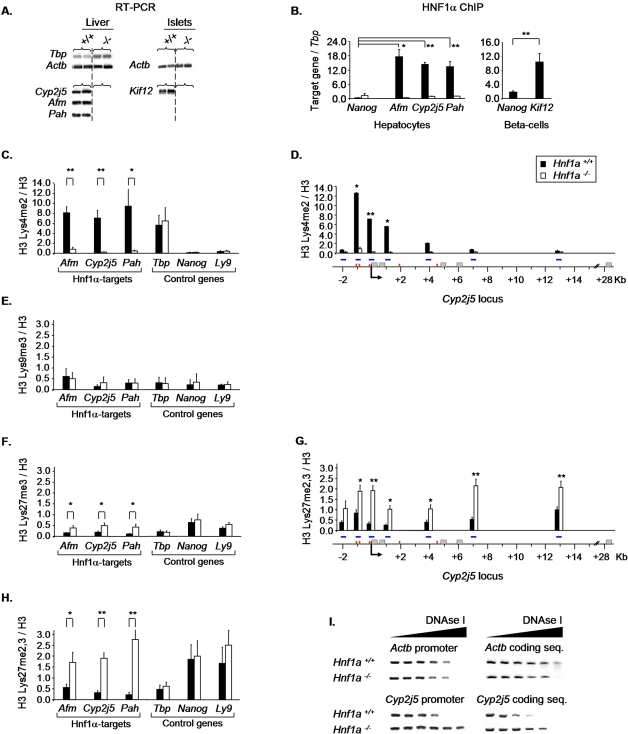
Inactive Hnf1α targets in Hnf1a−/− cells exhibit local enrichment of H3-Lys27me3, decreased H3-Lys4me2, and reduced DNAse I sensitivity.(A) RNA expression of tissue-specific Hnf1α targets (Afm, Cyp2j5, Pah, Kif12) and control genes (Tbp, Actb) in Hnf1a+/+ and Hnf1a−/− liver and islets. (B) ChIP analysis of Hnf1α occupancy in the promoter region of tissue-specific targets and a control gene (Nanog) in Hnf1a+/+ and Hnf1a−/− hepatocytes (Afm, Cyp2j5 and Pah, black and white bars respectively) and MIN6 beta-cells (Kif12, black bars). Results are normalized by Tbp enrichment. *p<0.05 and **p<0.01 relative to Nanog. (C–H) ChIP analysis of histone modifications in Hnf1α-targets and control genes in Hnf1a+/+ and Hnf1a−/− hepatocytes. For all genes the 5′ flanking regions are analyzed, except in D,G, where the entire Cyp2j5 locus is analyzed. Blue horizontal lines indicate amplicon positions, grey boxes are exons, red lines depict computationally predicted high-affinity HNF1 binding sites, and an arrow indicates the transcription start site. Graphs depict mean±SEM of the ratio of the percent input immunoprecipitated with anti-methyl specific H3 relative to anti-H3 antibodies in 3 independent experiments. Black bars represent Hnf1a+/+ and white bars Hnf1a−/− hepatocytes. *p<0.05 and **p<0.01 relative to Hnf1a+/+ hepatocytes. (I) General DNAse sensitivity of Cyp2j5. Representative PCR analysis of Cyp2j5 and Actb 5′ flanking and coding sequence regions after digestion of Hnf1a+/+ and Hnf1a−/− nuclei with increasing amounts of DNAse I. Results show reduced DNAse I sensitivity in Hnf1a−/− nuclei in the Cyp2j5 region, but not in the Actb control locus.